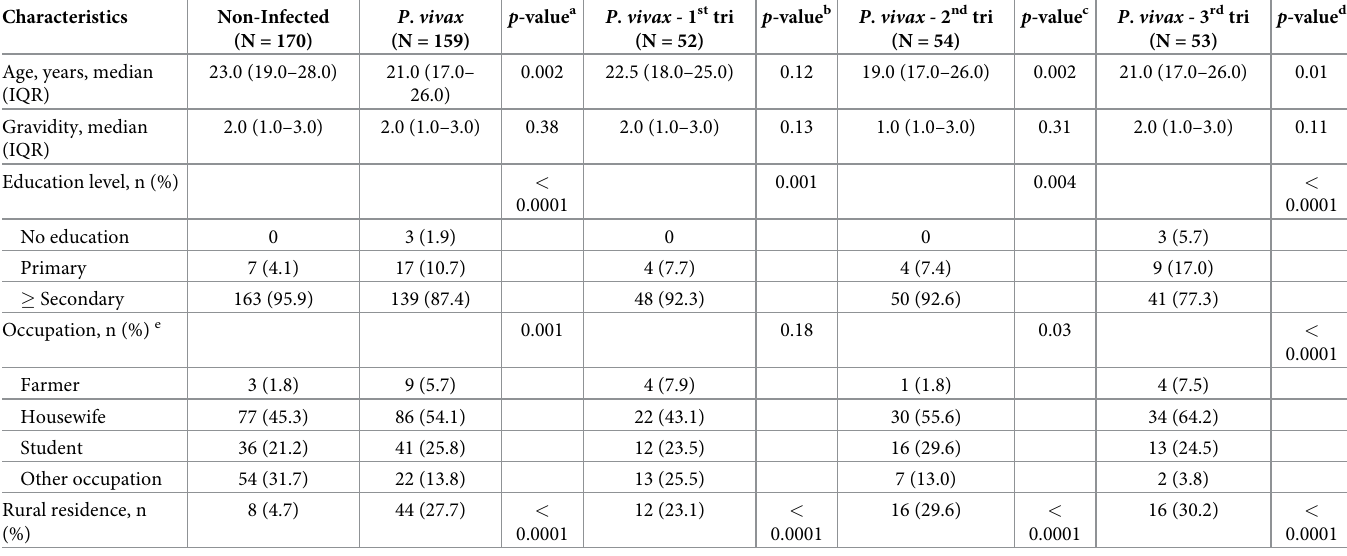
Table 1. Demographic characteristics of the mothers participating in the study, according to infection and gestational trimester of first infection.